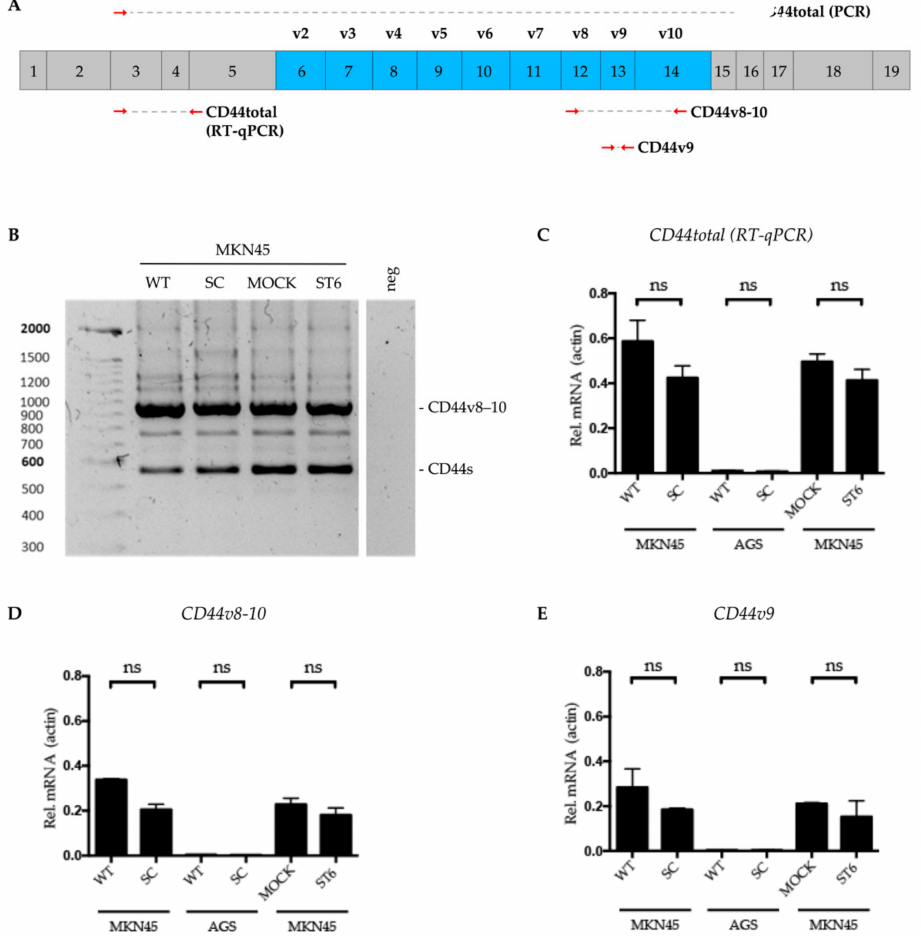
Figure 2. CD44 gene expression analysis in gastric cancer cell line models. ( A ) Primer scheme for CD44 isoform analysis through PCR and RT-qPCR. → forward primer; ← reverse primer. ( B ) Analysis of the total set of CD44 isoforms expressed in gastric cancer cell line models of O -glycan truncation (MKN45 SC and ST6) and their control counterparts (MKN45 WT and MOCK). Expected molecular weights are matched with CD44 transcript isoforms. ( C – E ) Analysis of the mRNA expression of CD44 isoforms by RT-qPCR: total CD44 ( C ) CD44v8-10 ( D ) and CD44v9 ( E ). Results were normalized to the actin transcript expression. Analysis were performed in two biological replicates with two technical replicates each and are shown as average ± SD. ns = non